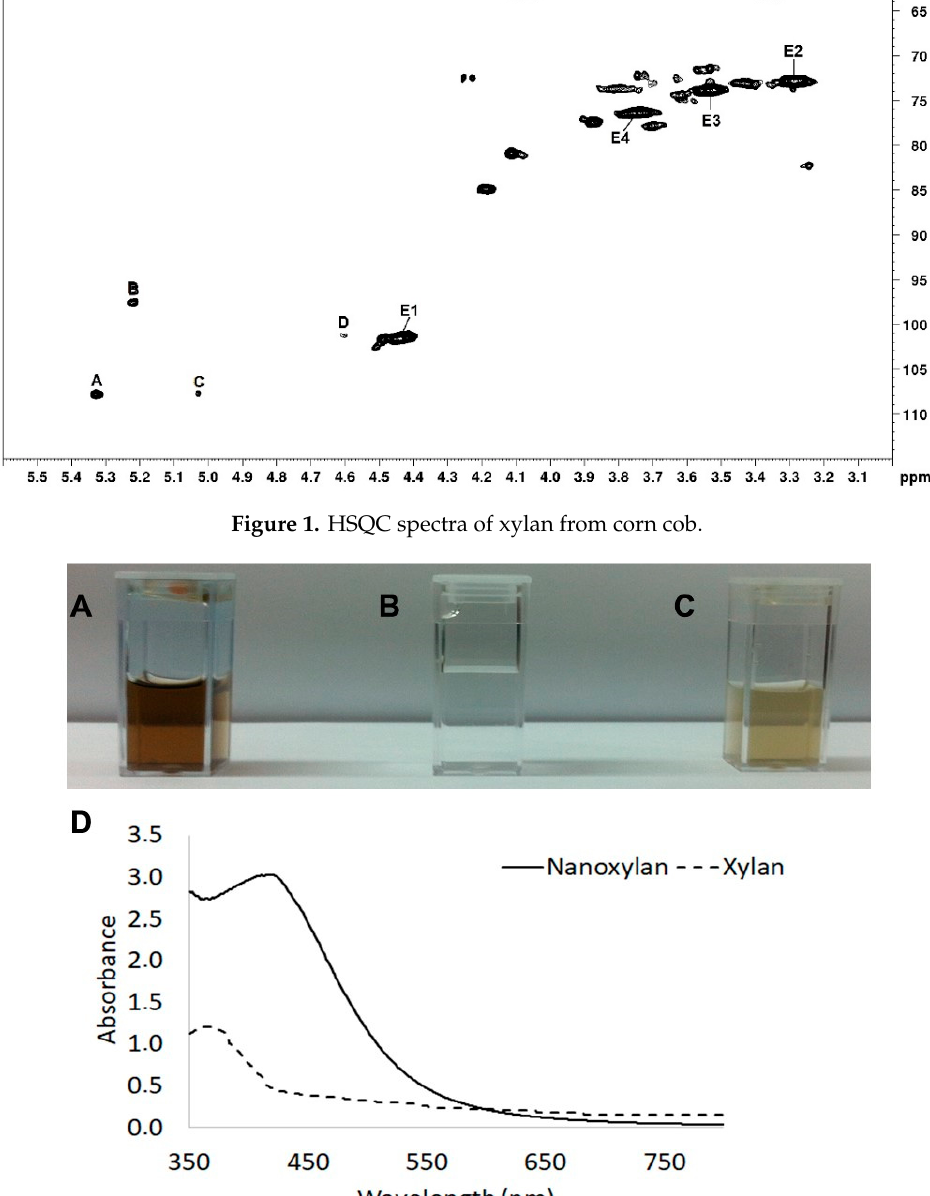
Figure 2. Nanoxylan suspension ( A ), silver nitrate 1 mM solution ( B ), and xylan solution (10 mg/mL) ( C ). The darker color in the nanoxylan suspension is related to the reduction in the silver particles. UV–vis absorption spectrum of the nanoxylan suspension and xylan solution ( D ).